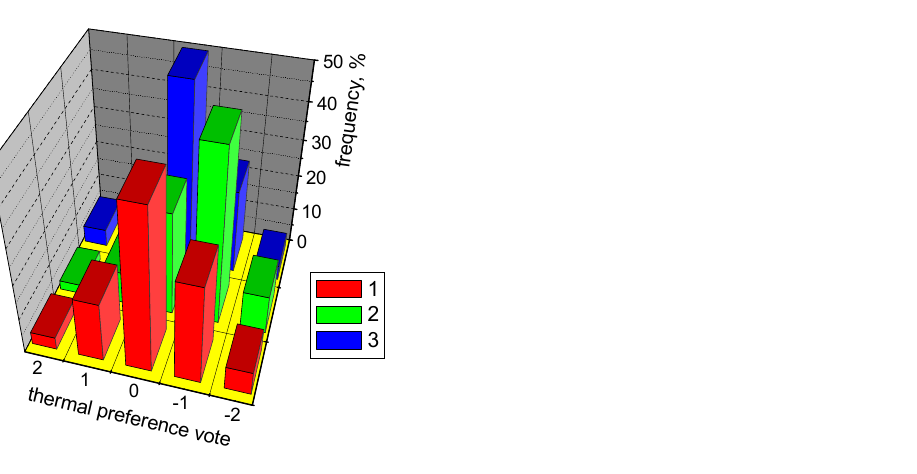
Figure 6. Distribution of thermal preference votes in the Courthouse (1), “A” building (2) and “Energies” (3).